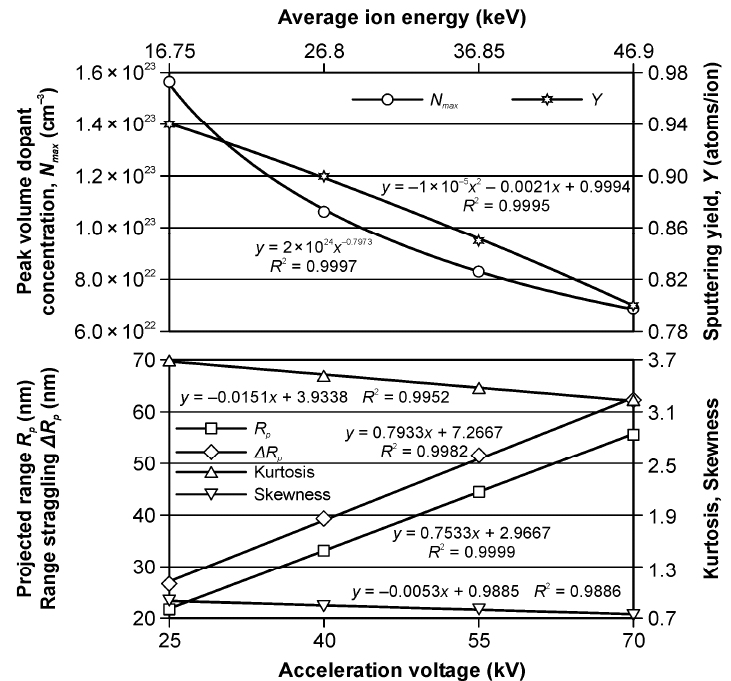
Figure 7. The modelled values of peak volume dopant concentration, sputtering yield, projected range, range straggling, kurtosis, and skewness as functions of the acceleration voltage and the average ion energy. Table 4. The values of the parameters of nitrogen peak and the sputtering yield.